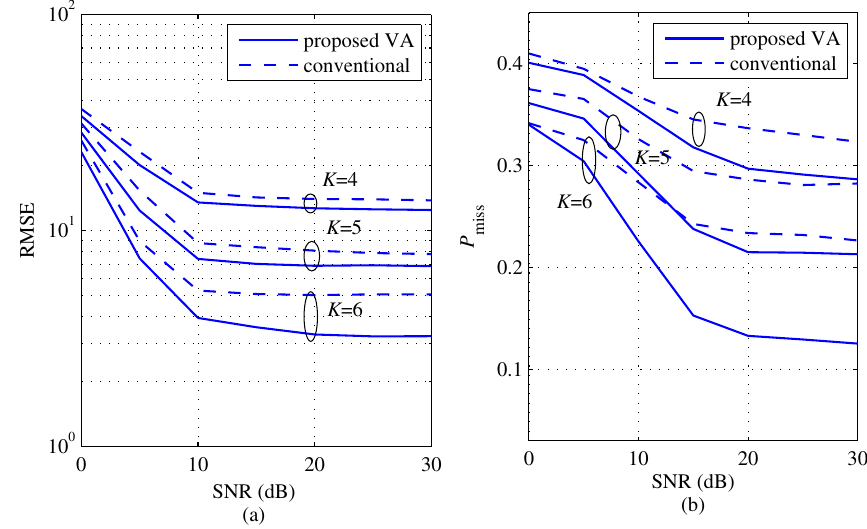
Figure 9. RMSE and probability of missing detection comparisons between the proposed and the conventional algorithms according to SNR for several K s with M = 2 ( θ 1 = − 10 ◦ , θ 2 = 8 ◦ ) and K Ex = 2 K − 1; ( a ) RMSE; ( b ) probability of missing detection.